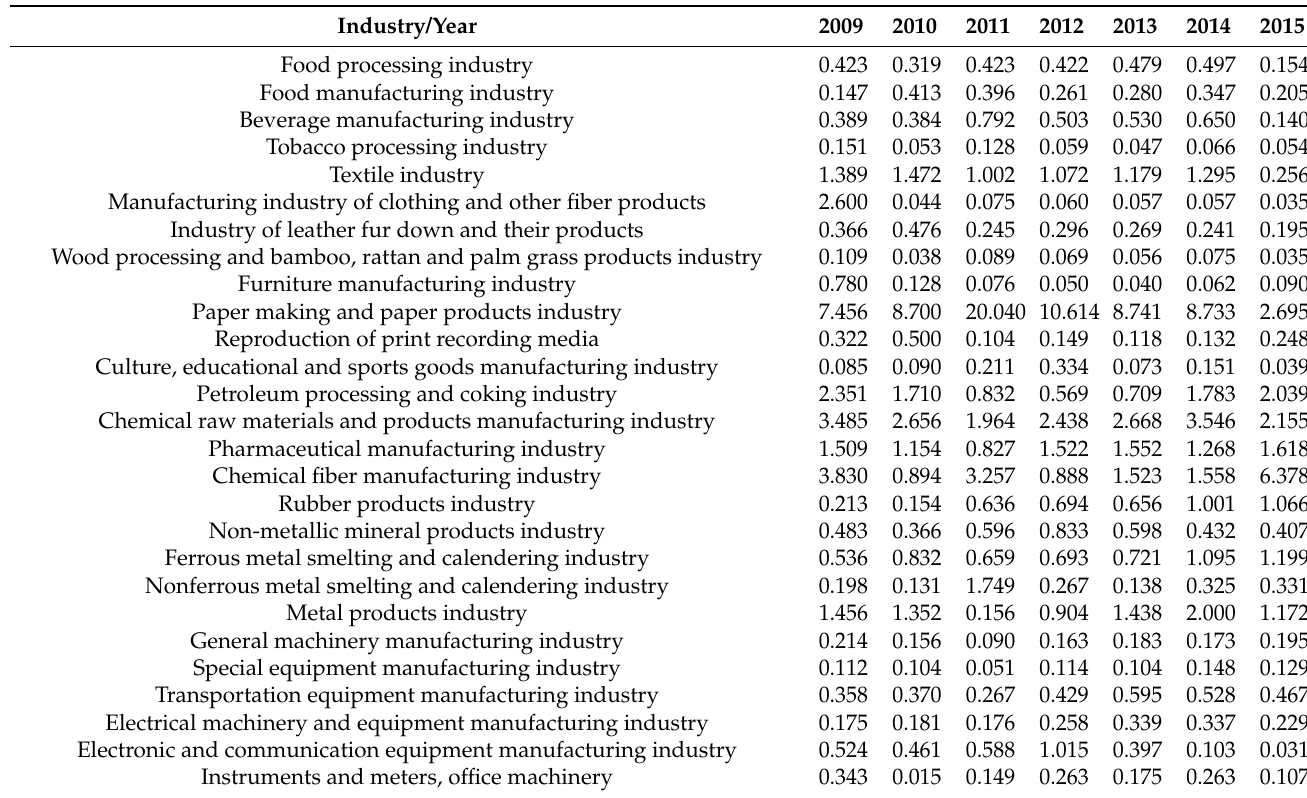
Table 4. Calculation of environmental regulation intensity in different industries and